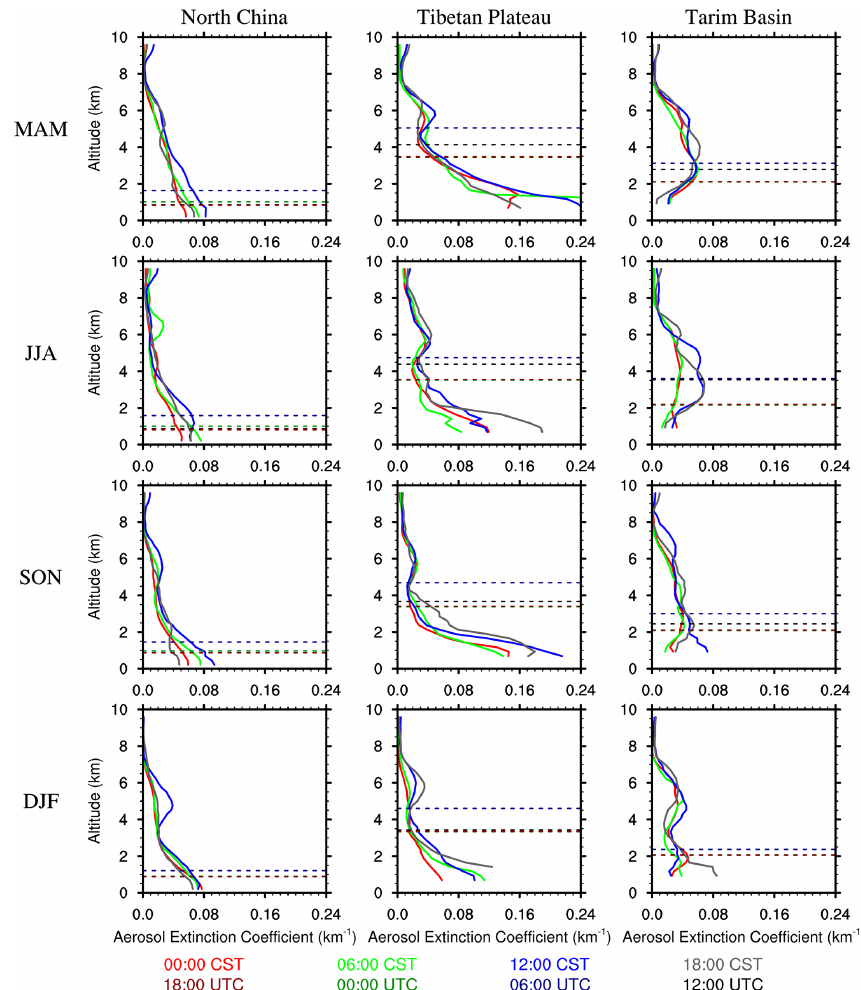
Figure 7. The 6h (00:00, 06:00, 12:00, and 18:00CST) vertical profiles of the 1064nm aerosol extinction coefficients (km − 1 ) observed from CATS by season over the three regions. The dashed lines represent the height of the regional mean planetary boundary layer (km) from the NCEP FNL reanalysis data every 6h (00:00, 06:00, 12:00, and 18:00